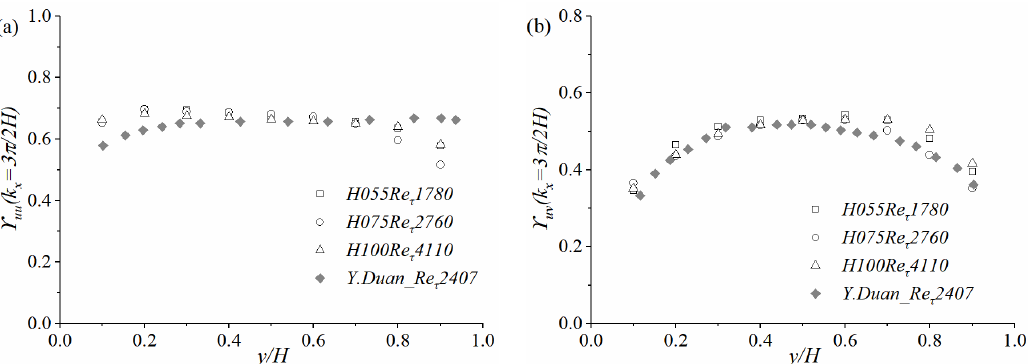
Figure 10. Wall-normal profiles of the contributions of VLSMs to (a) turbulent kinetic energy and (b) Reynolds shear stress. ( b ) Reynolds shear